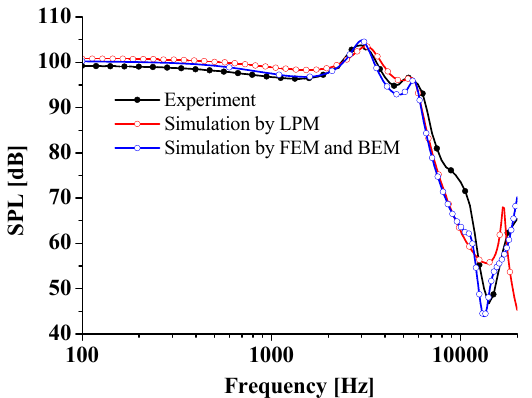
Figure 13. Comparison of experiment and simulation.